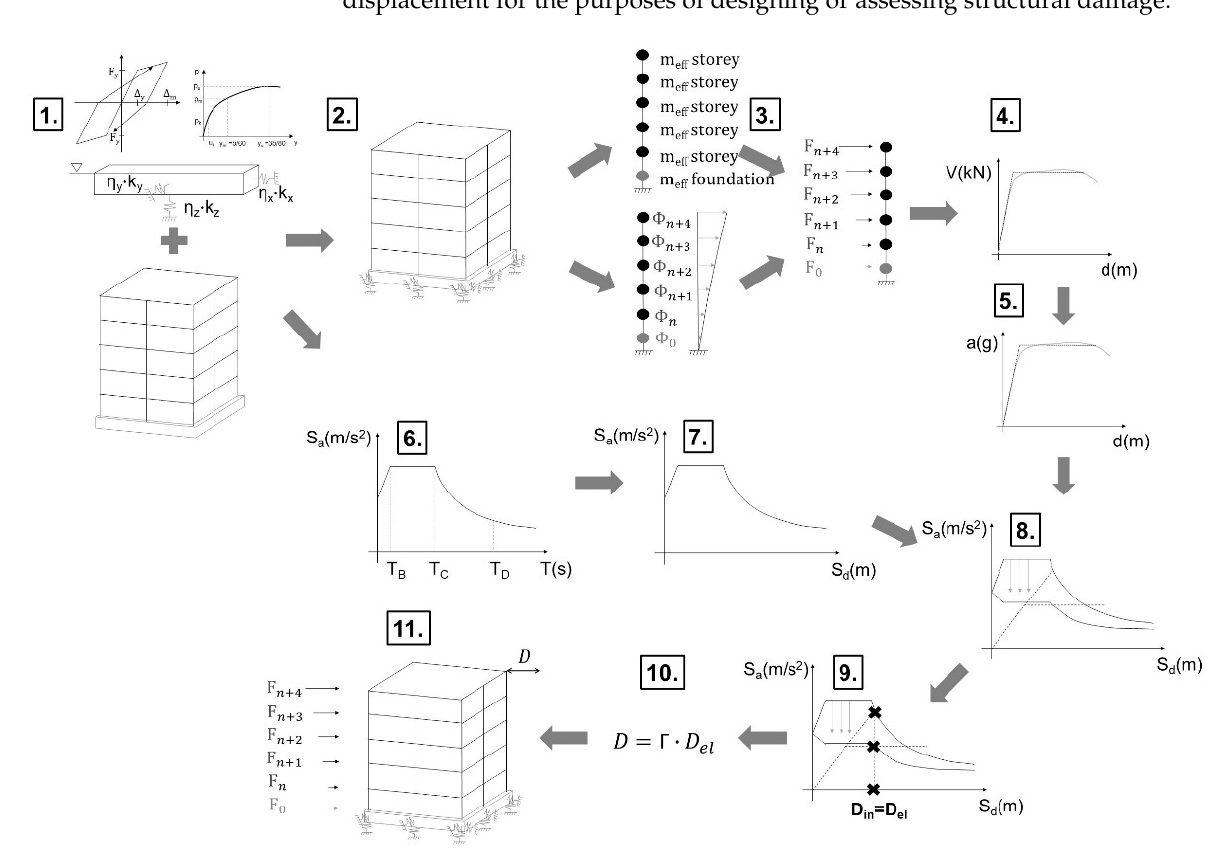
Figure 8. Algorithm for implementing the new application of the N2 method on soil-structure systems.